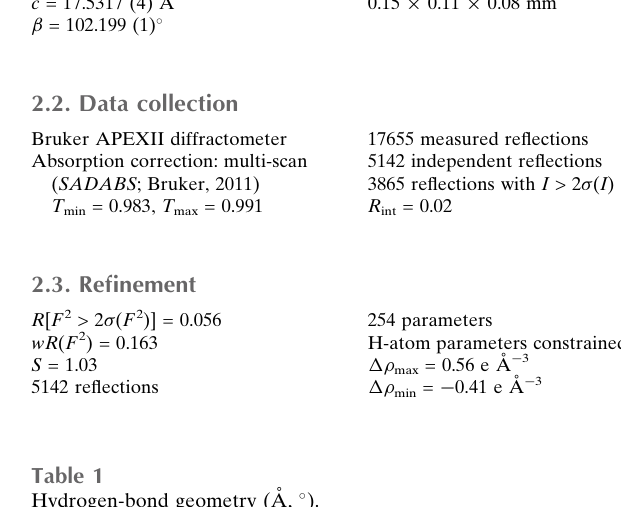
Hydrogen-bond geometry (A˚ , (cid:2) ). Cg 3 is the centroid of ring